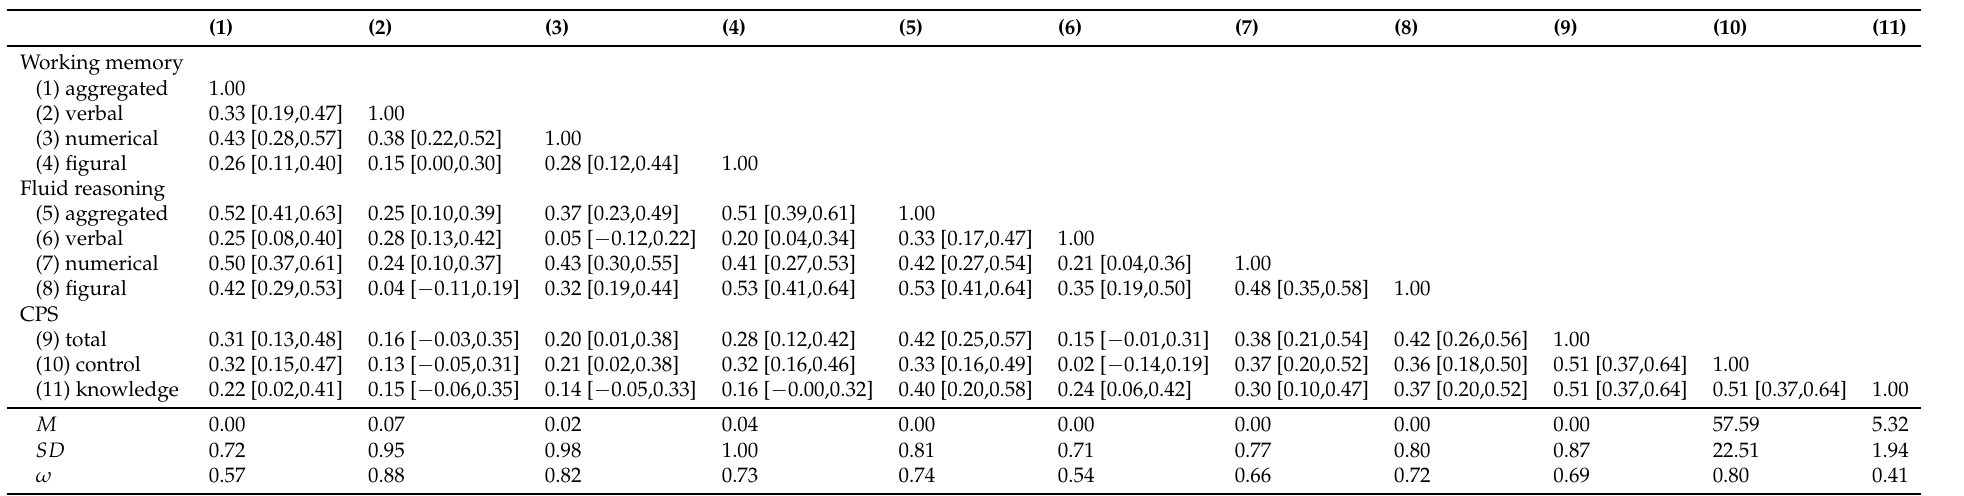
Table 1. Descriptive statistics, reliabilities, and